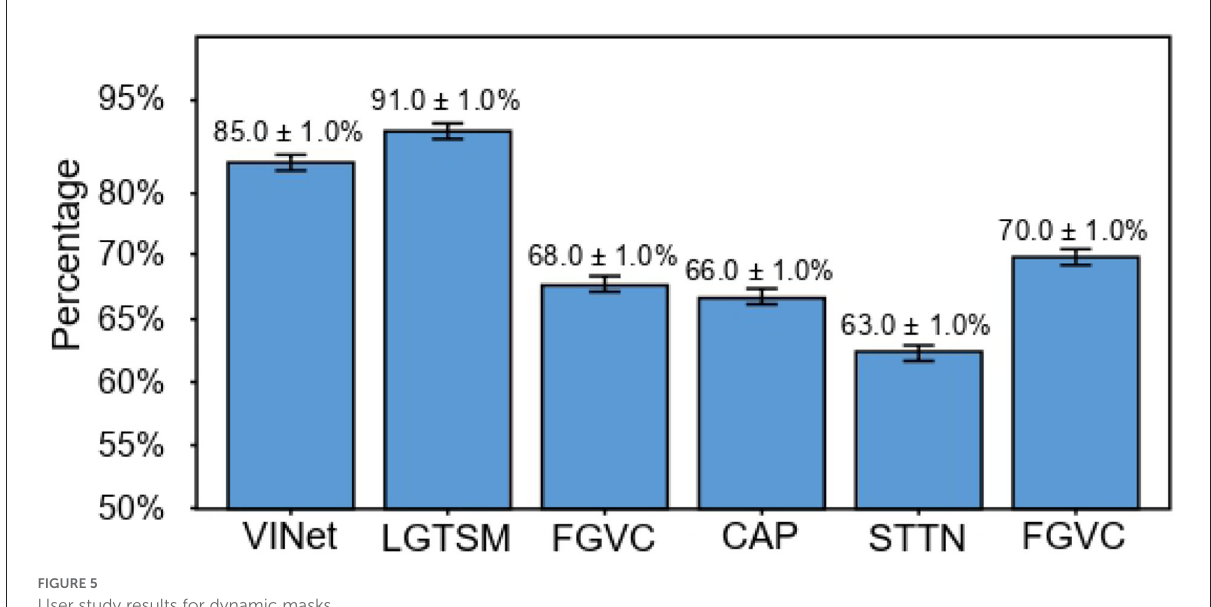
FIGURE5 User study results for dynamic masks.